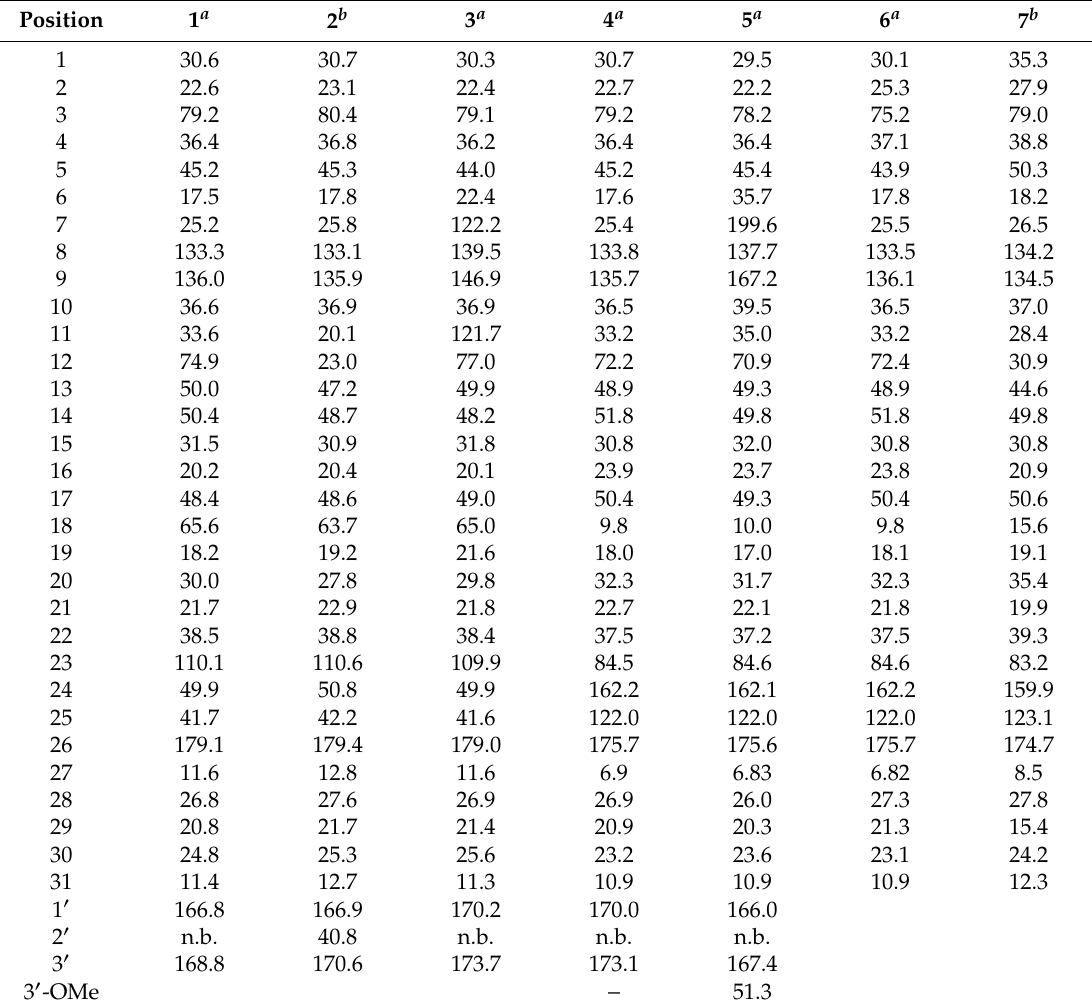
Table 2. 13 C NMR spectroscopic data (100 MHz) for compounds